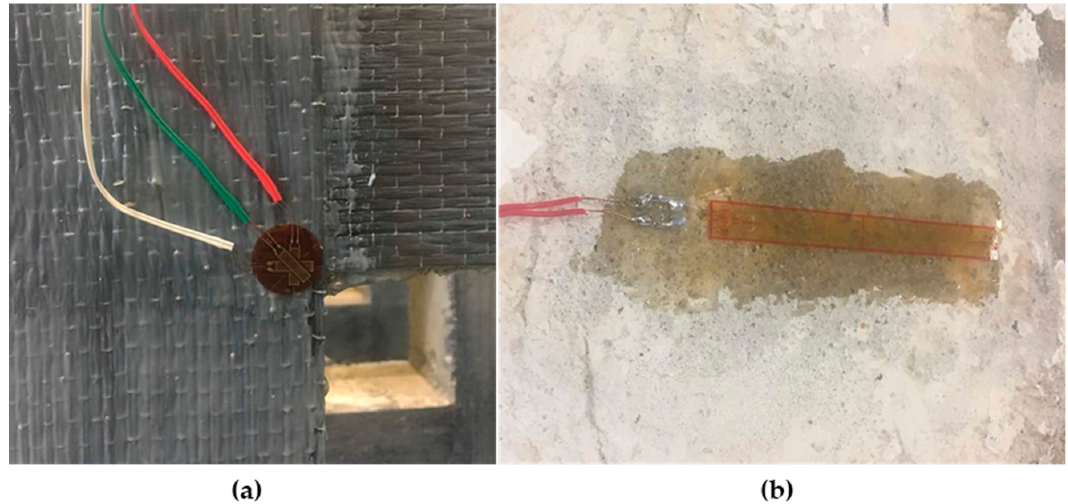
Figure 5. Arrangement of: ( a ) rosette strain gauge; and ( b ) uniaxial strain gage.